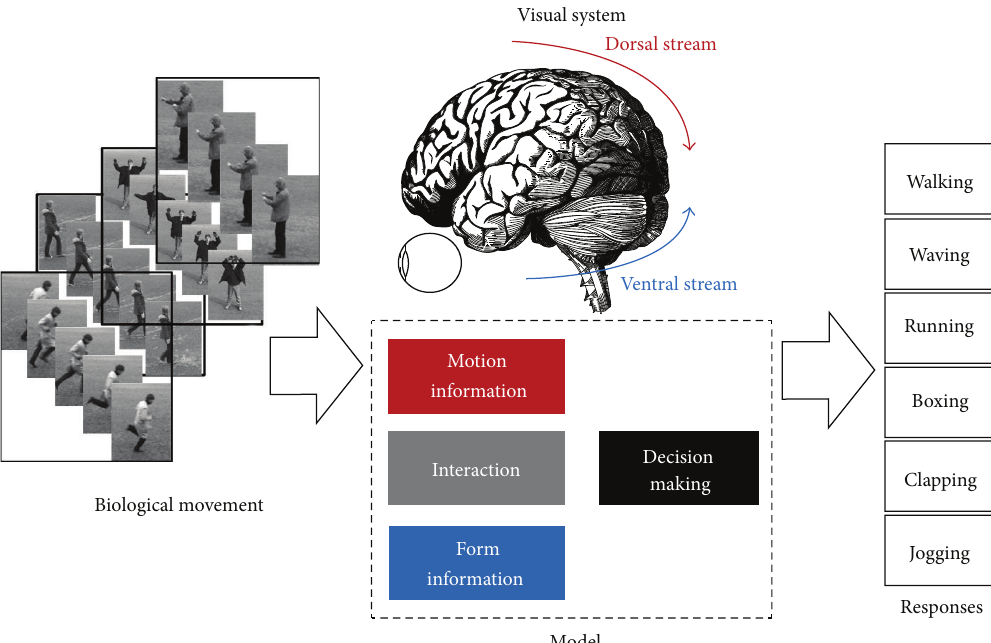
Figure 1: Figure reveals the analytical visual system model. The proposed approach suggests utilization of better interaction and classifier in model of the biological movement. To develop the computational models for recognition mechanism and characterize the recognition responses regarding various actions. The model is the perspective of the original model and consists of particular computations of motion and form feature data. The model operates for high-dimension of input streams and the outcome is a combination of the ventral and dorsal processing